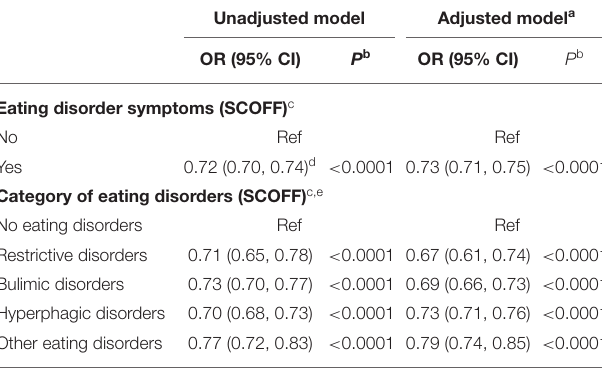
TABLE 7 | Association between mastery (PMS) and eating disorder symptoms (NutriNet-Santé cohort study, 2014). Unadjusted model